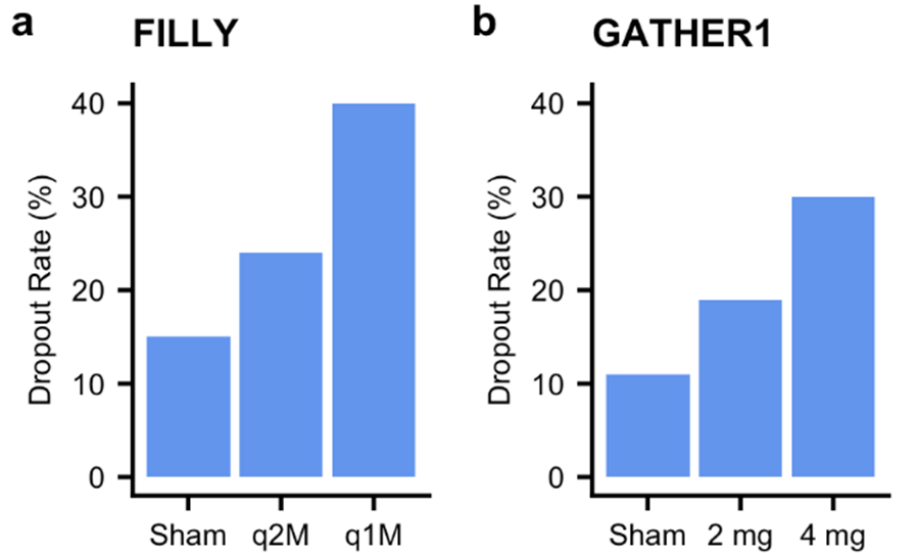
Figure 2. Increased drop-out rates in the treatment arms of complement inhibition studies. Dropout rates in the sham and treatment arms of the ( a ) FILLY [27] and ( b ) GATHER1 [28] studies. q2M: treatment every 2 months; q1M: treatment every 1 month.